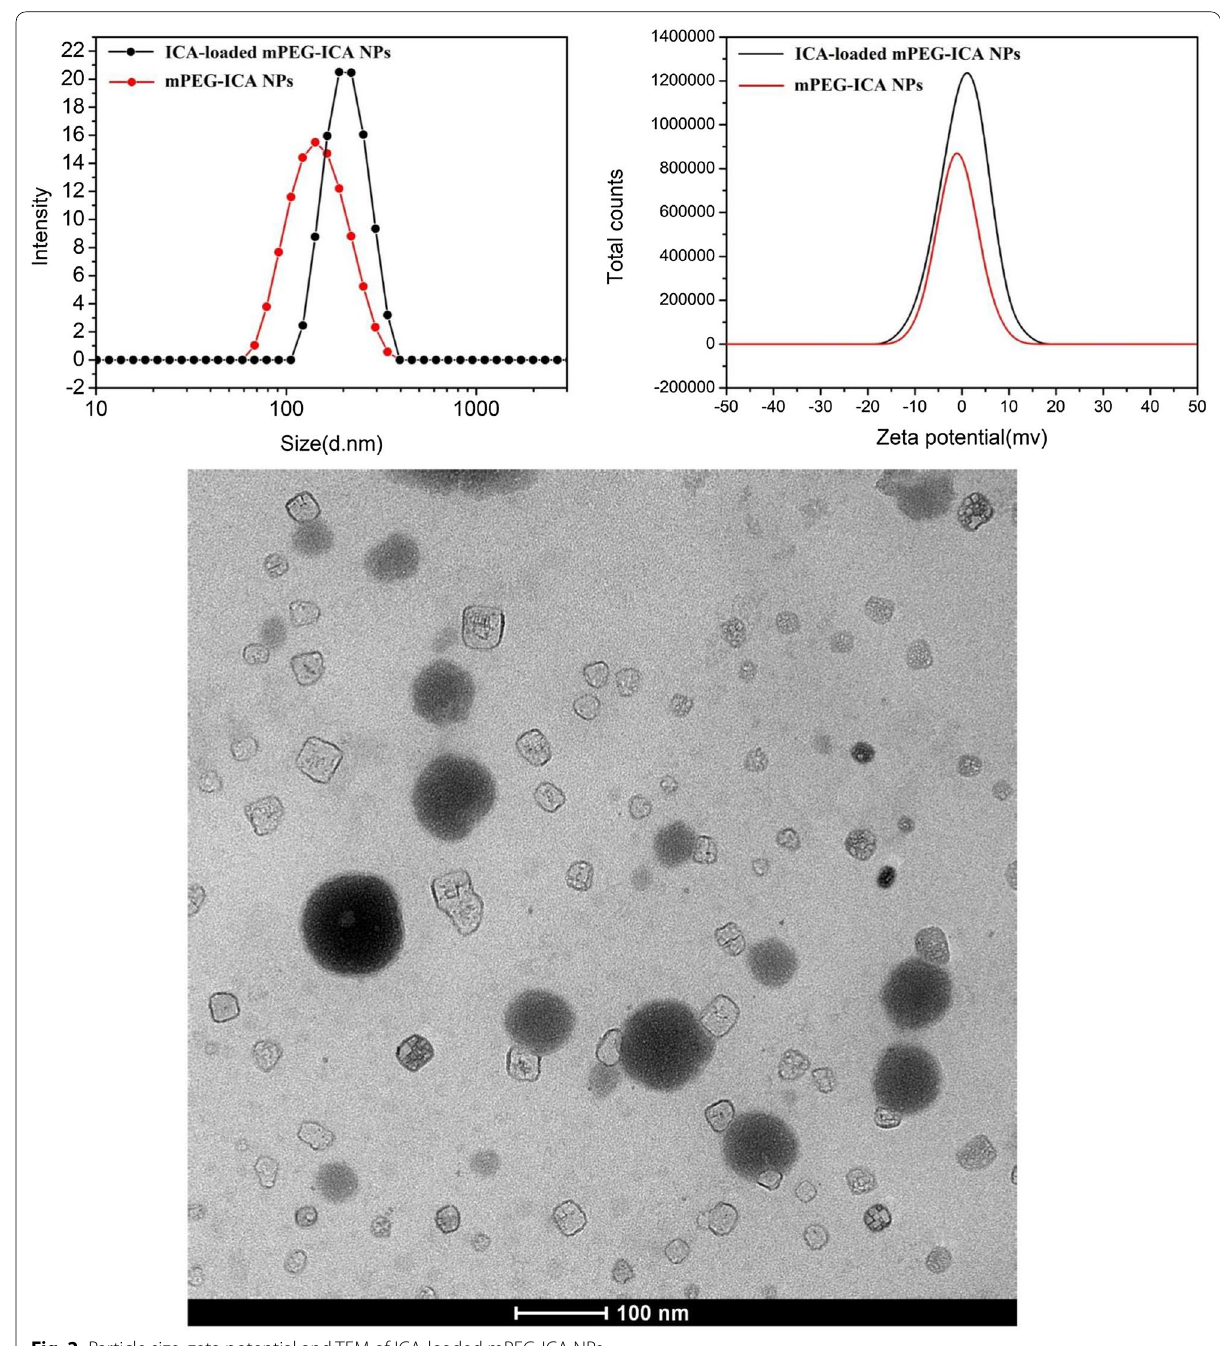
Fig. 2 Particle size, zeta potential and TEM of ICA-loaded mPEG-ICA NPs